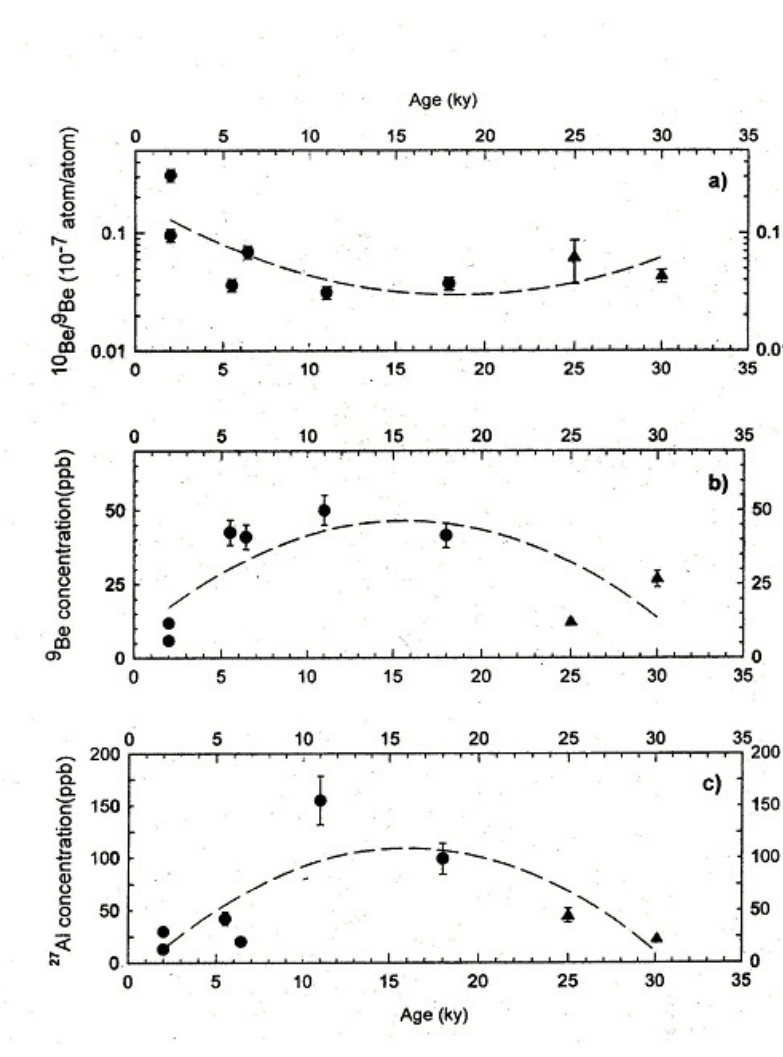
FIGURE 1. Measured concentrations of intrinsic Be, Al, and 10 Be concentrations in foraminiferal calcite from the equatorial Pacific Ocean box cores ERDC 125 (circles) and ERDC 135